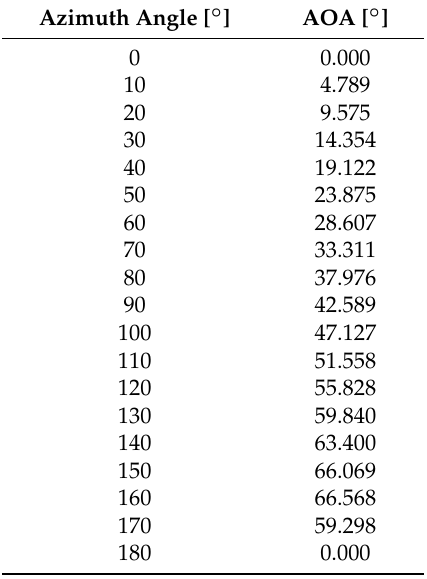
Table 3. Angle of attack in a blade revolution ( λ = 1.1).